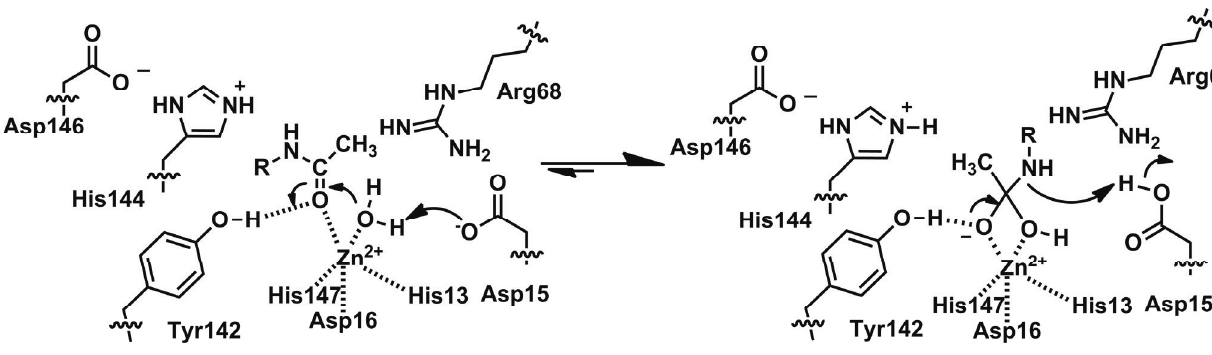
Figure 4. Proposed Mechanism for